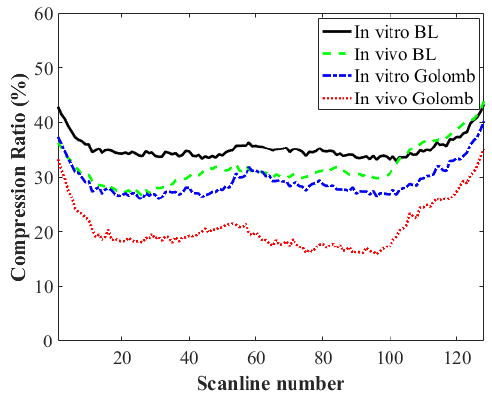
Figure 5. Comparison of compression ratios (%) of the proposed BL and exponential Golomb codes.